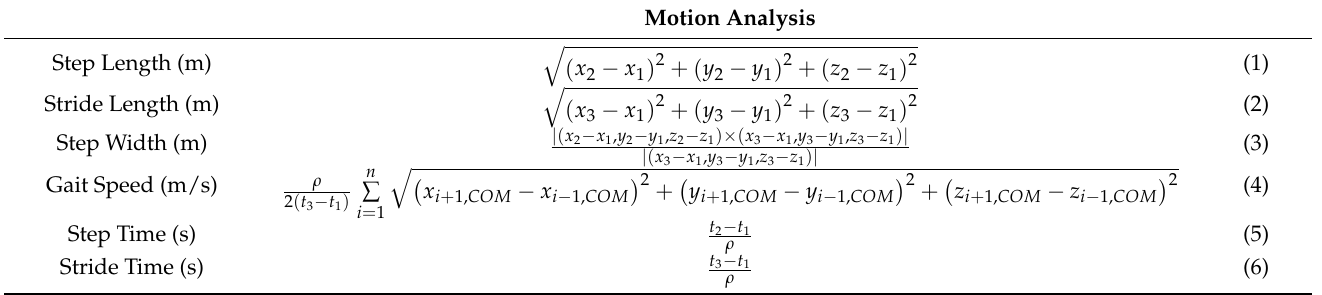
Table 2. List of calculation formulas of spatiotemporal gait parameters in the Kinect V2 and Motion Analysis system [35,45,46]. 3D coordinates of RHEE in Motion Analysis or “right ankle” in Kinect V2 at the first and second right foot strike were represented by ( x ) and ( x ) , respectively. 3D coordinates of LHEE in Motion Analysis or “left ankle” in Kinect V2 at the left foot strike 3 , y 3, z 3 1 , y 1, z 1 were represented by ( x 2 , y 2, z 2 ) . Average positions of the sacrum, LASI and RASI or “spine base” in the Kinect V2 were represented by ( x ) . t COM , y COM , z COM 1 , t 2 , and t 3 stood for time frames of first right foot strike, the left foot strike, and the second right foot strike. ρ stood for the sampling frequency of Motion Analysis or Kinect V2.